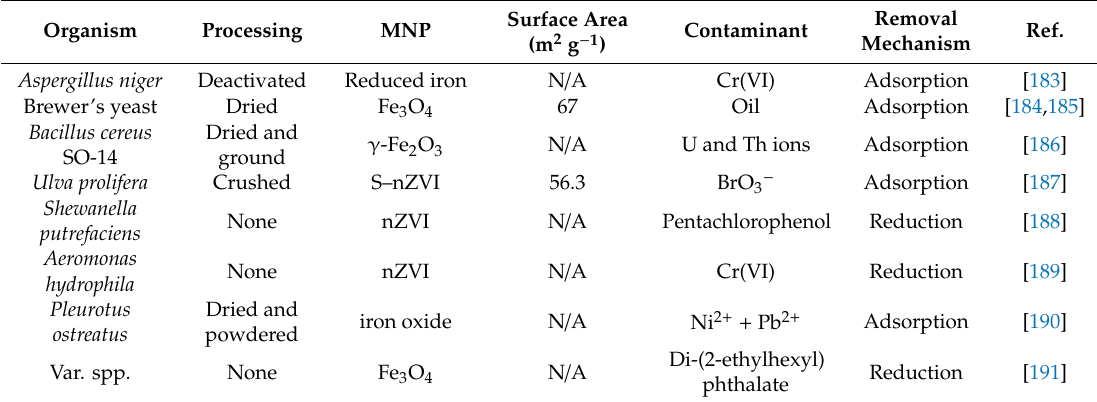
Table 10. Microorganisms used in the formation of magnetic